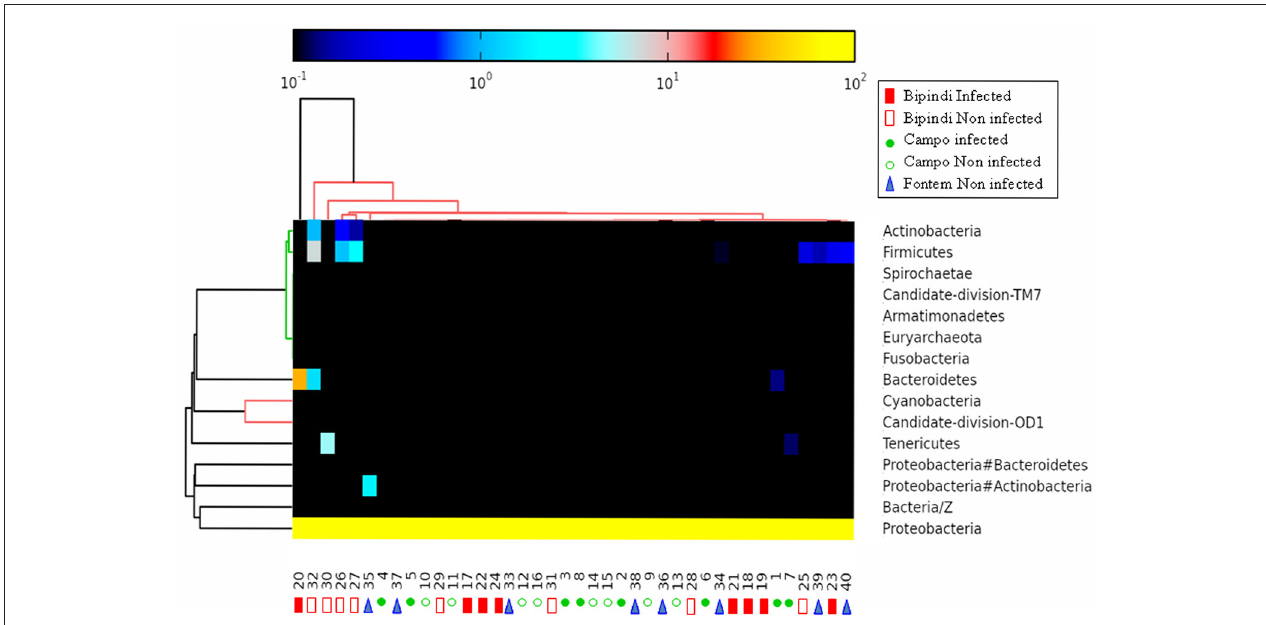
FIGURE 4 | Heat map analysis of the distribution and abundance of the bacterial phyla in midgut samples. The samples did not cluster together, indicating highly variable bacterial communities. Numbers 1–8: infected samples from the Campo focus; Numbers 9–16: non-infected samples from the Campo focus; Numbers 17–24: infected samples from the Bipindi focus; Numbers 25–32: non-infected samples from the Bipindi focus; Numbers 33–40: non infected samples from the Fontem focus.